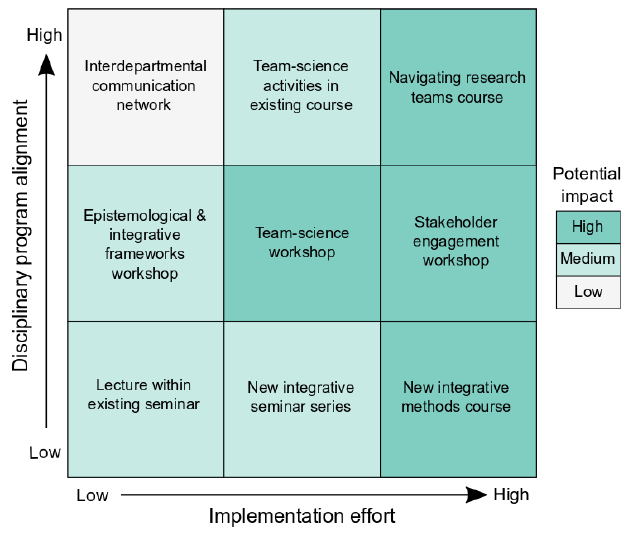
Fig. 1 . Integrative research training opportunities that can be implemented into existing graduate programs. Opportunities are ranked according to disciplinary program alignment